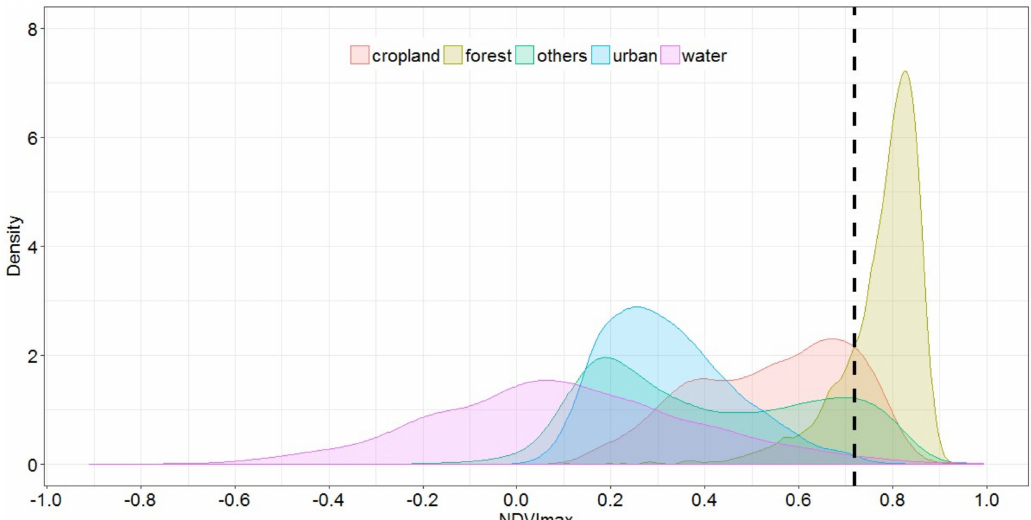
Figure 5. Kernel density distribution plots of forest/non-forest (cropland, water, forest, and other types) from the dry and wet season maximum time series Landsat-based NDVI values over the corresponding six years, and the black dashed indicted the threshold value (0.72) of NDVI max to distinguish between forest and